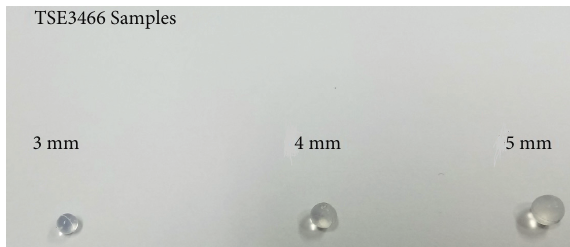
Figure 1: Elastomer samples of TSE3466 3mm, 4mm, and 5mm diameter particles after being removed from